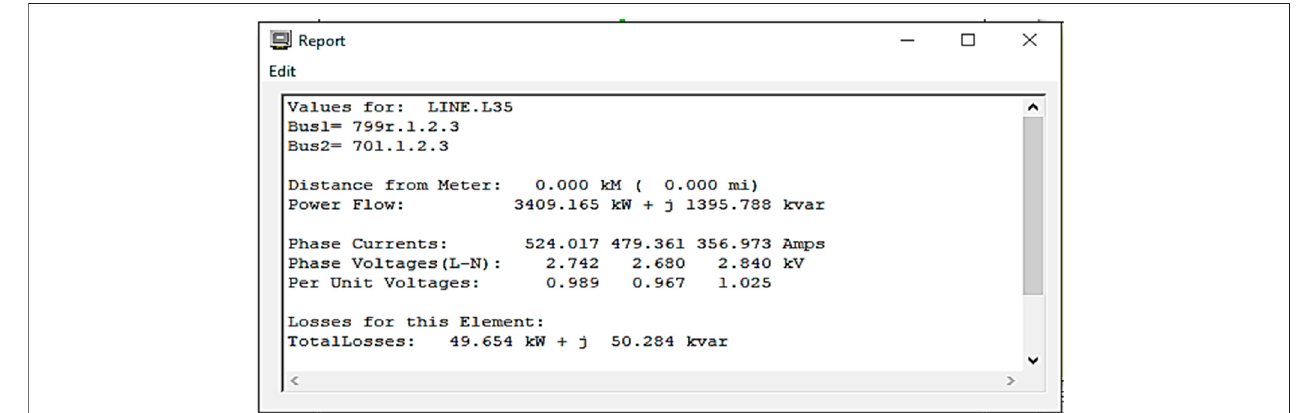
FIGURE 10 | Line.L35.